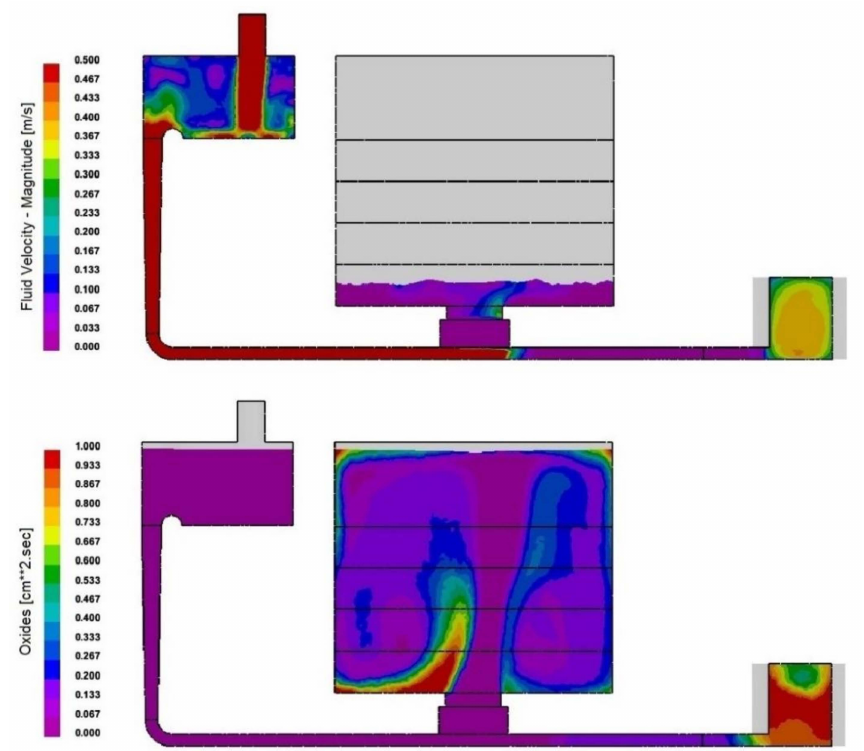
Figure 8. Simulations of the melt velocity and amount of oxides in the naturally pressurized gating system with 20 ppi foam filter and vortex